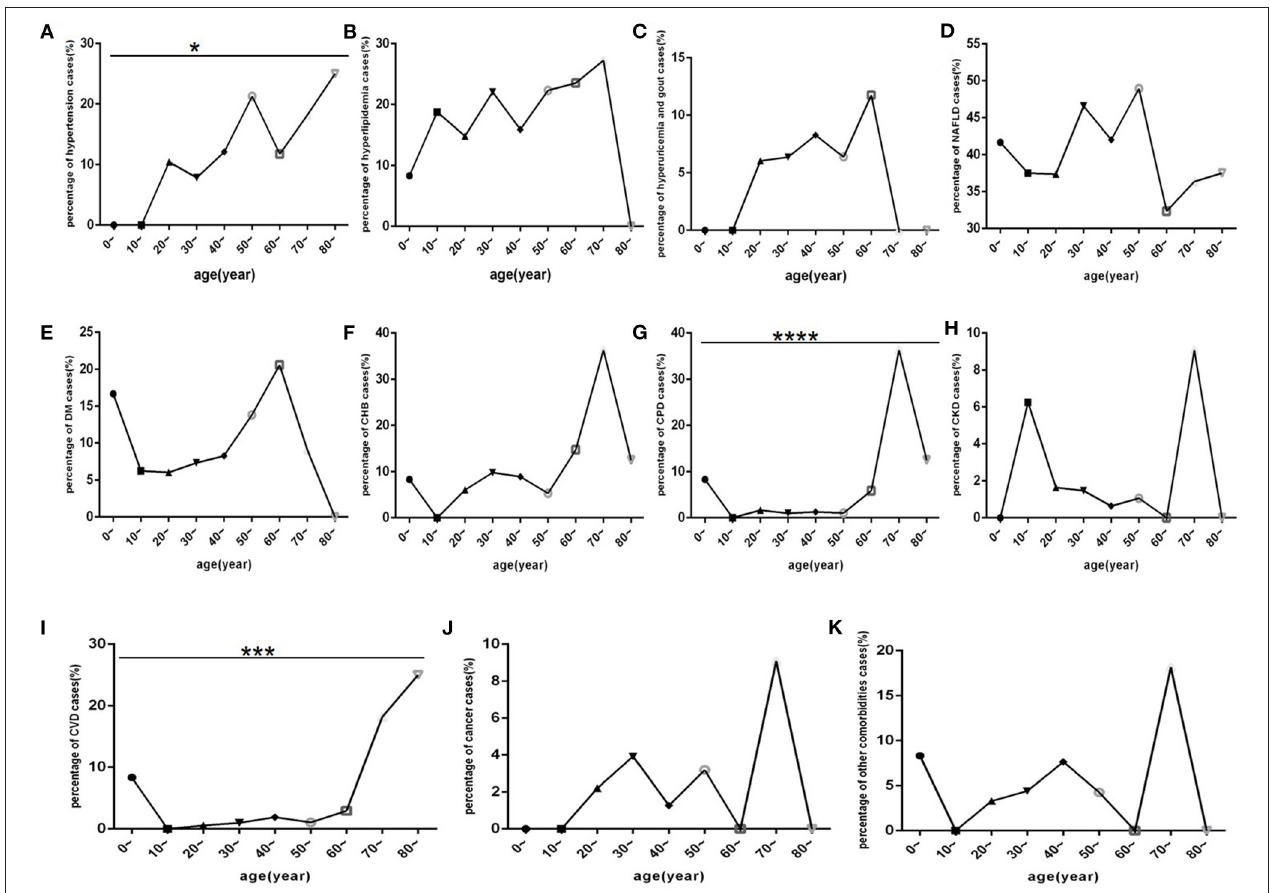
FIGURE 7 | Comparison of the percentage of each comorbidity case among different age-interval groups ( n = 718). COVID-19, coronavirus disease 2019; NAFLD, non-alcoholic fatty liver disease; DM, diabetes mellitus; CHB, chronic hepatitis B; COPD, chronic obstructive pulmonary disease; CKD, chronic kidney disease; CVD, cardiovascular disease. (A) Hypertension. (B) Hyperlipidaemia. (C) Hyperuricaemia and gout. (D) NAFLD. (E) DM. (F) CHB. (G) COPD. (H) CKD. (I) CVD. (J) Cancer. (K) Other. Unpaired one-way ANOVA was used for intergroup comparisons (G, P < 0.0001; I, P < 0.001; A, P < 0.05; B, C, D, E, F, H, J, K, all P > 0.05). * p < 0.05, *** p < 0.001, **** p < 0.001.